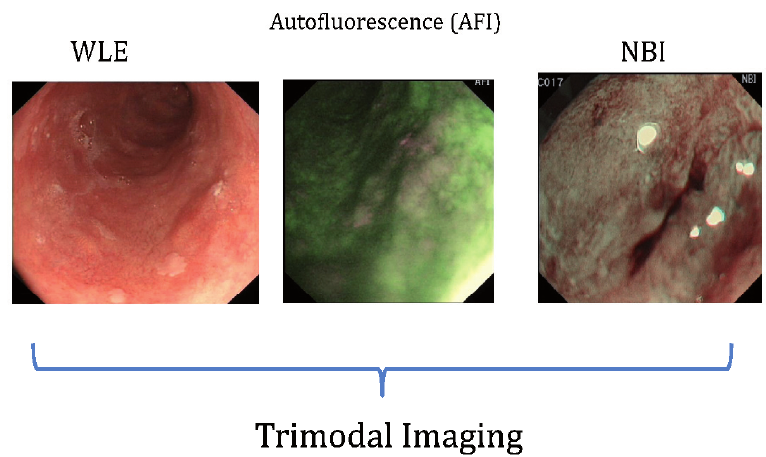
Figure 2. Trimodal endoscopic imaging of an early cancerous lesion in the